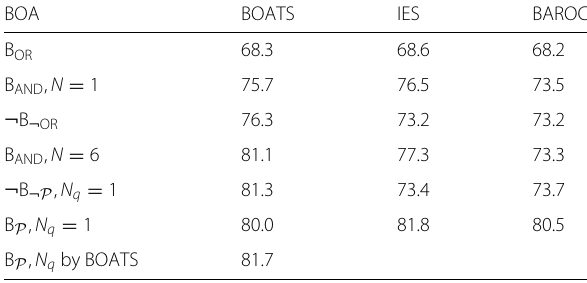
Table 2 Comparison of algorithms for BOA training